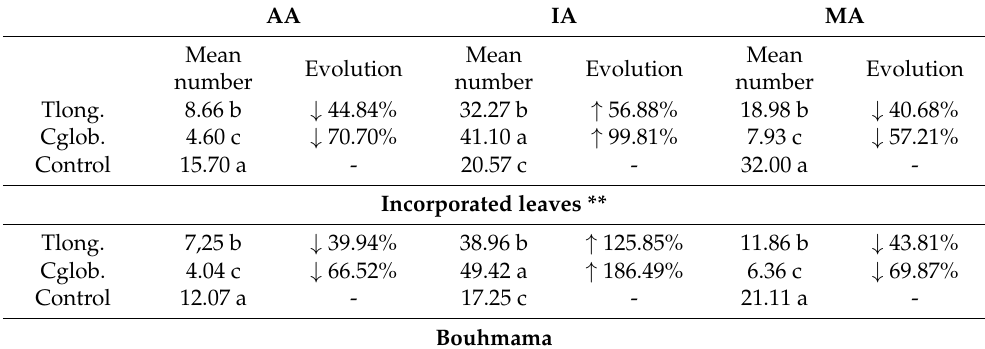
Table 1. Impact of biological treatments of senescent apple leaves with invert emulsions on numbers of asci-ejecting ascospores (AA), immature asci (IA), and morphologically mature asci (MA) of wintering form of Venturia inaequalis . R’Haouat Unincorporated Leaves * AA IA MA Mean Mean Mean Evolution Evolution Evolution number number number Tlong. 8.66